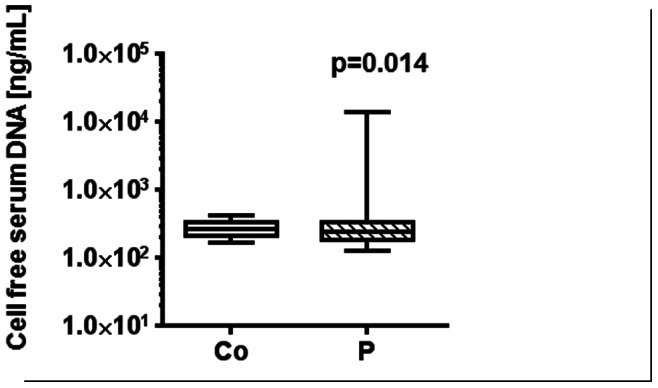
Increased levels of circulating DNA after exposure to halo alkanes.The box plot (the median values are shown as a cross lines) implicates total cell-free serum DNA levels in patients exposed to halo-methane/or -ethane fumigants (exposed subjects, P) as compared with the healthy control group (Co). The significance was determined by Kruscal-Wallis test and Dunn’s post-test (P = 0.014).